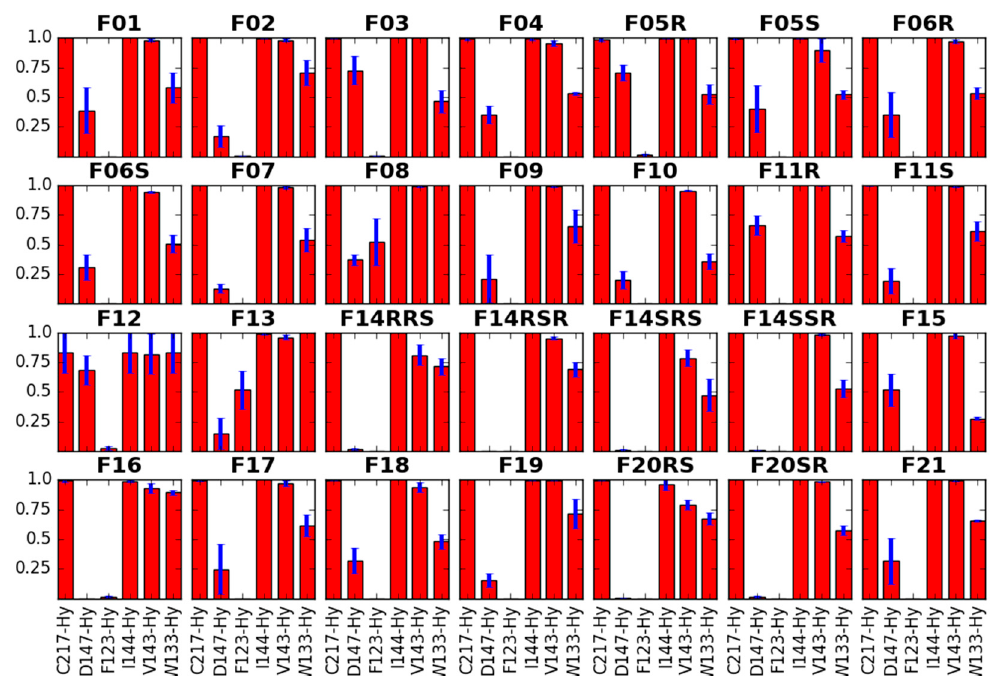
Figure 7 . Interactions of the anilide’s aromatic ring with the receptor residues. Red bars represent the mean frequency of contacts with a particular residue, and blue bars show standard error of the mean. Data are collected from last 10 ns of production in 3 replicas. In x -axis label given is the residue’s name and number as well as type of the contact (Hb—hydrogen bond, Hy—hydrophobic, A—aromatic).